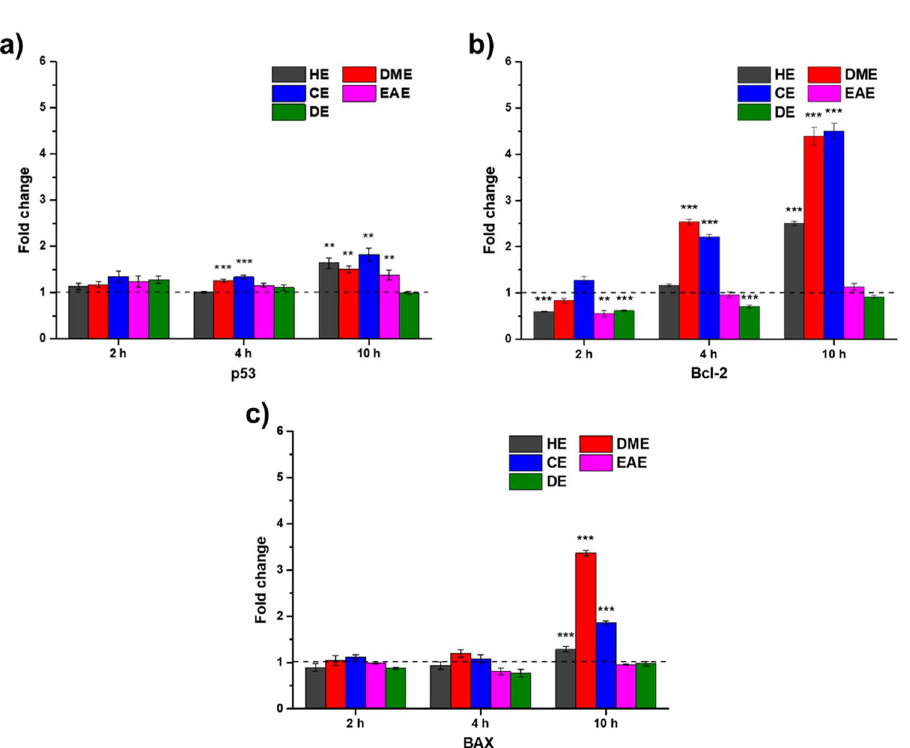
Figure 7. Gene expression analysis in HeLa cells. ( a ) p53 , ( b ) Bcl-2 , and ( c ) BAX expression. **p < 0.01 and ***p < 0.001 indicates statistical significances compared to negative